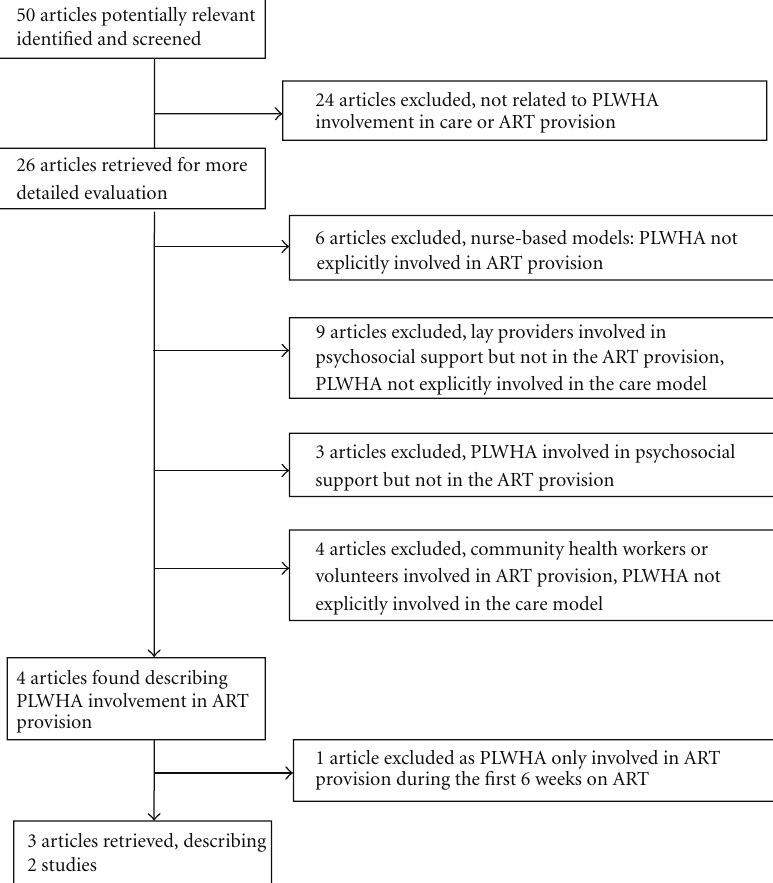
Figure 2: Results of literature search on PLWHA involvement in ART